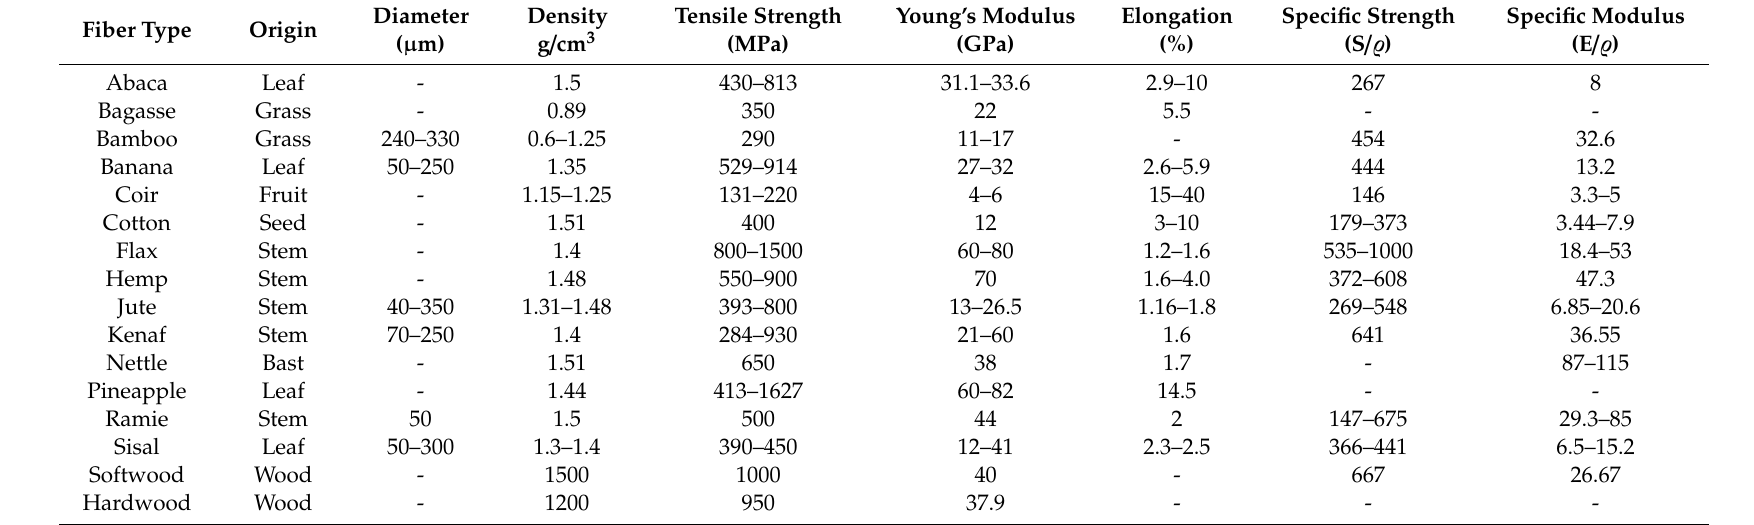
Table 2. Natural fibers origin, physical and mechanical properties